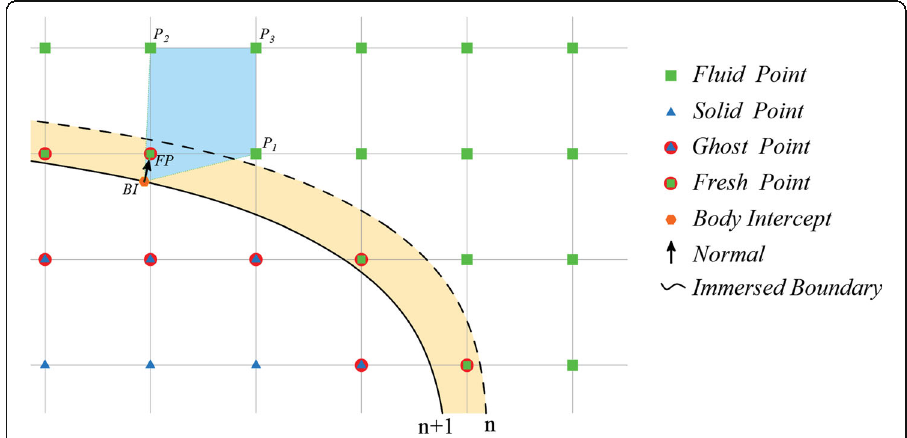
Fig. 2 The emergence of fresh point due to the boundary motion from time level n to time level n +